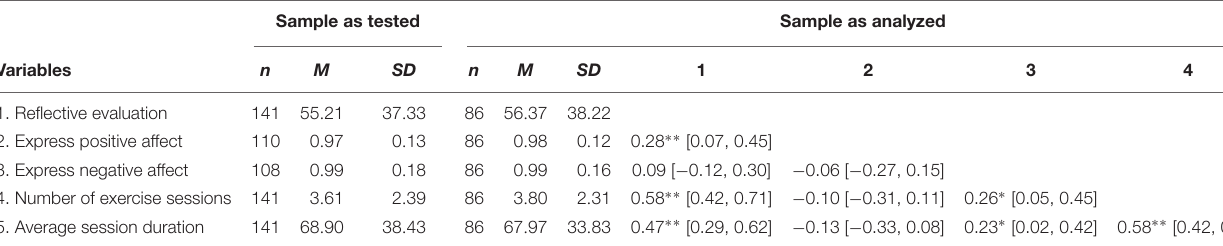
TABLE 1 | Sample sizes, means, and standard deviations for all main study variables and correlations. Sample as tested Sample as